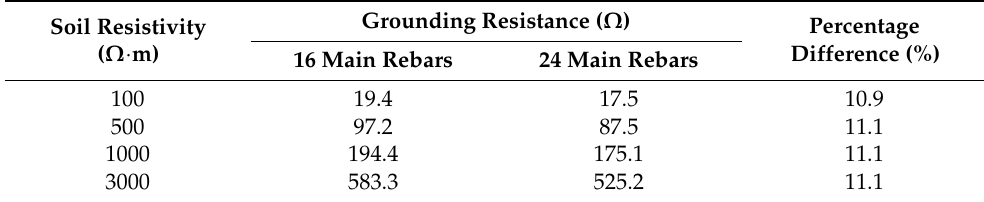
Table 7. Distance between pile foundations at each voltage